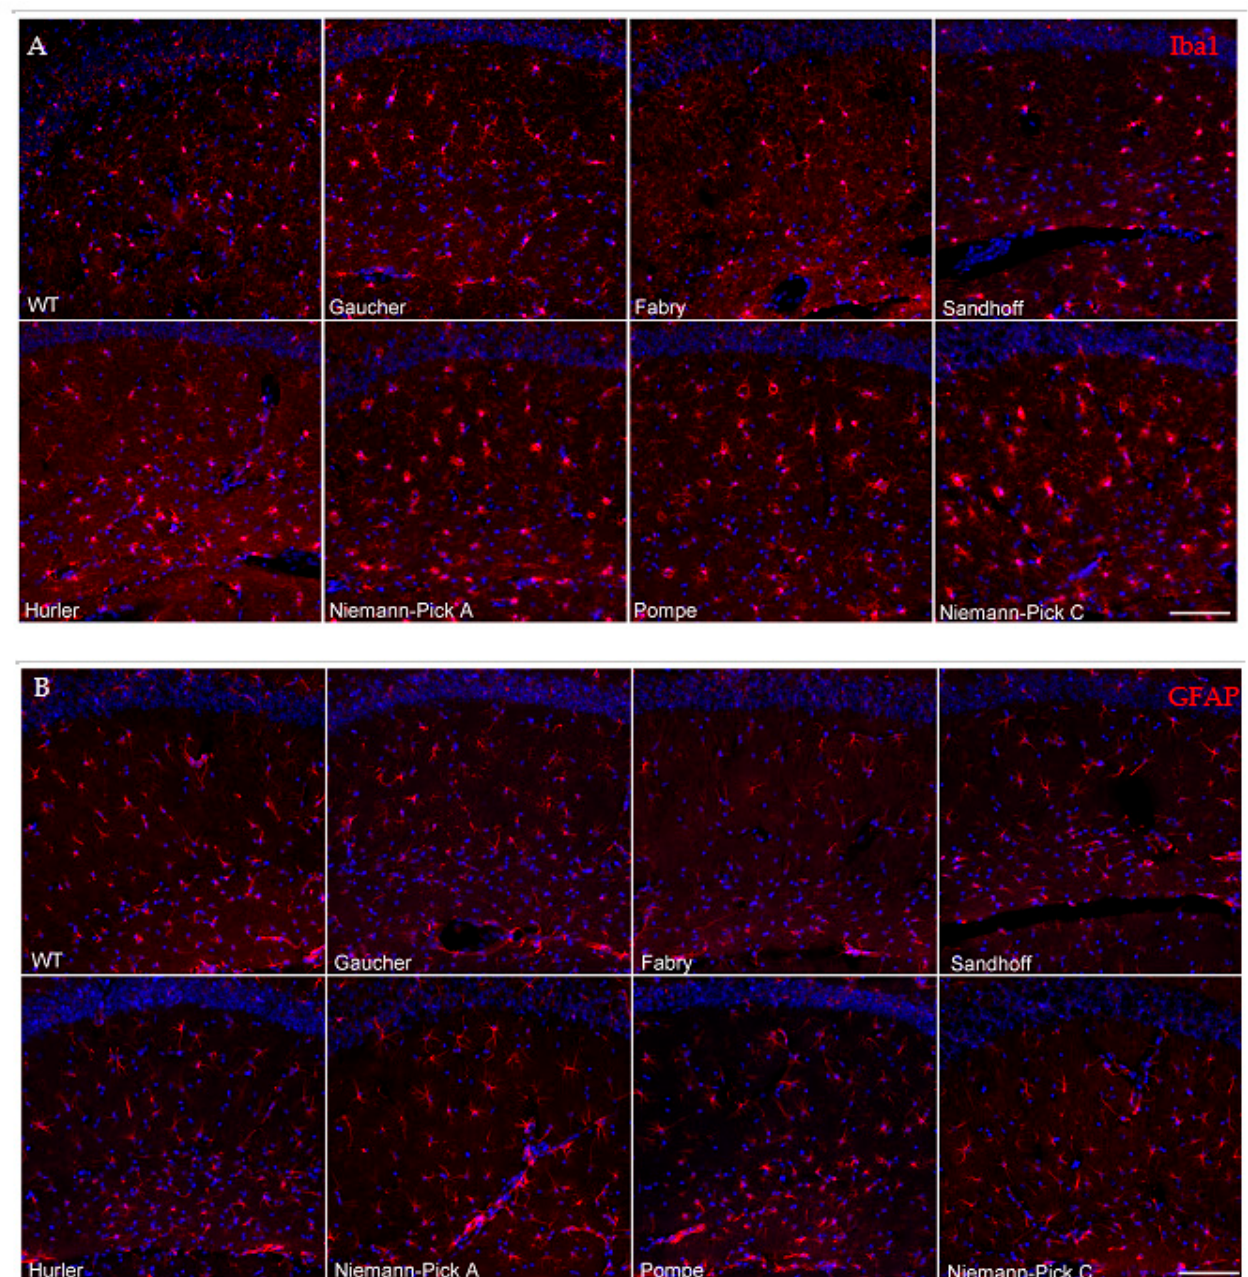
Figure 2. Neuroinflammatory profiles of lysosomal storage disease model mice hippocampi differ in severity and do not correlate with the presence of abnormal protein aggregates. Hippocampal Iba1 immunoreactivity ( A ) revealed mild to moderate microglial activation in the Sandhoff, Niemann–Pick A, Hurler and Pompe models, as evidenced by overt enlargement of cell bodies. The Niemann–Pick C mice displayed the most severe microglial activation of the disease models evaluated. No activation was observed in the Gaucher and Fabry mice. GFAP immunoreactivity ( B ) revealed only slight astroglia increases in the Pompe model, with no overt changes in astrocytosis in Gaucher, Fabry, Sandhoff, Niemann–Pick A, Hurler and Niemann–Pick C disease model mice. Nuclei are shown in blue with DAPI counterstaining (scale bar 100 μ m).